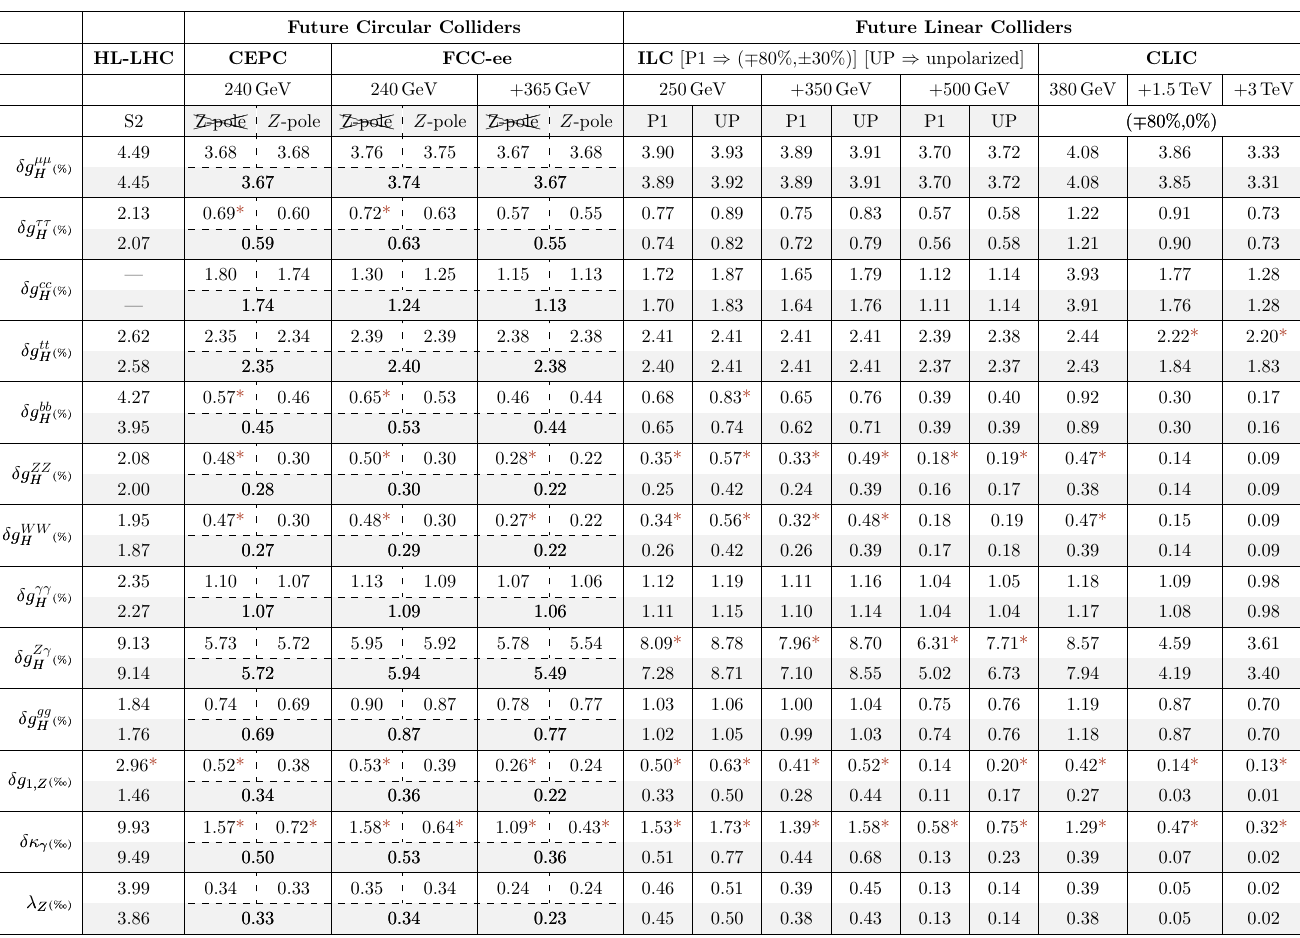
Table 1 . Global one-sigma reach of future collider measurements on Higgs and triple-gauge couplings. All projections include current EW measurements and HL-LHC prospects. Projections in grey rows assume perfect EW measurements. The numbers marked with a * are then (cid:24)(cid:24)(cid:24)(cid:24)XXXX improved by more than 10%. \ Z -pole" and \ Z -pole" refer to the inclusion of new Z -pole runs at circular colliders. The results are graphically presented in (cid:12)gure 2. The e(cid:11)ects of a Z -pole run at circular colliders is stressed in (cid:12)gure